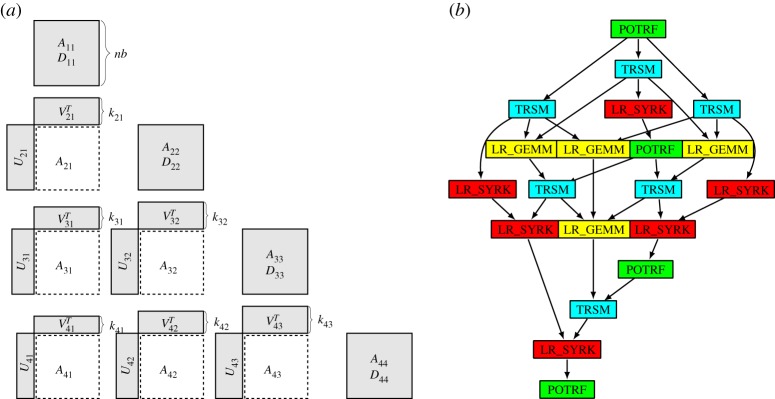
An originally dense symmetric positive definite matrix decomposed into tiles (a) and a DAG for its Cholesky factorization (b). (Online version in colour.)